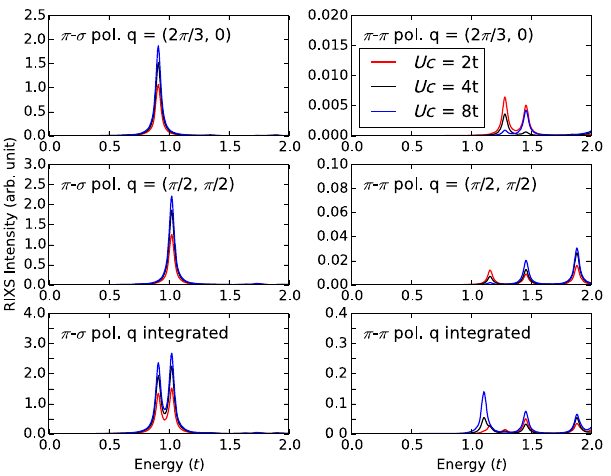
FIG. 8. Exact RIXS cross section calculated using exact diagonalization for n ¼ 1 (half filling) and for three different 2 t , 4 t , and 8 t [the model, values of the core-hole potential: U c ¼ its parameters (except for U ), and the exact diagonalization c method are the same as in the main text]. The left (right) panels show the RIXS spectra for the π − σ ( π − π ) relative polarization. The top, middle, and bottom panels show spectra calculated at q ¼ ð π = 2 ; π = 2 Þ , q ¼ ð 2 π = 3 ; 0 Þ , and integrated over all momenta 0 direction along the nodal direction and along the q y ¼ accessible on a 12-site cluster ( “ q integrated ” ). Elastic response is excluded, and each RIXS spectrum is calculated at the incident energy corresponding to the main ( “ L 3 ” ) XAS peak at half